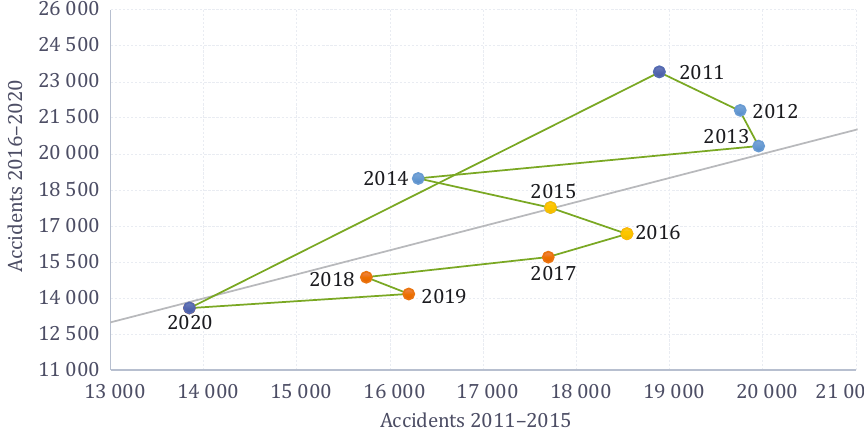
Figure 12. IPTA diagram of the polynomial trend, 2 nd